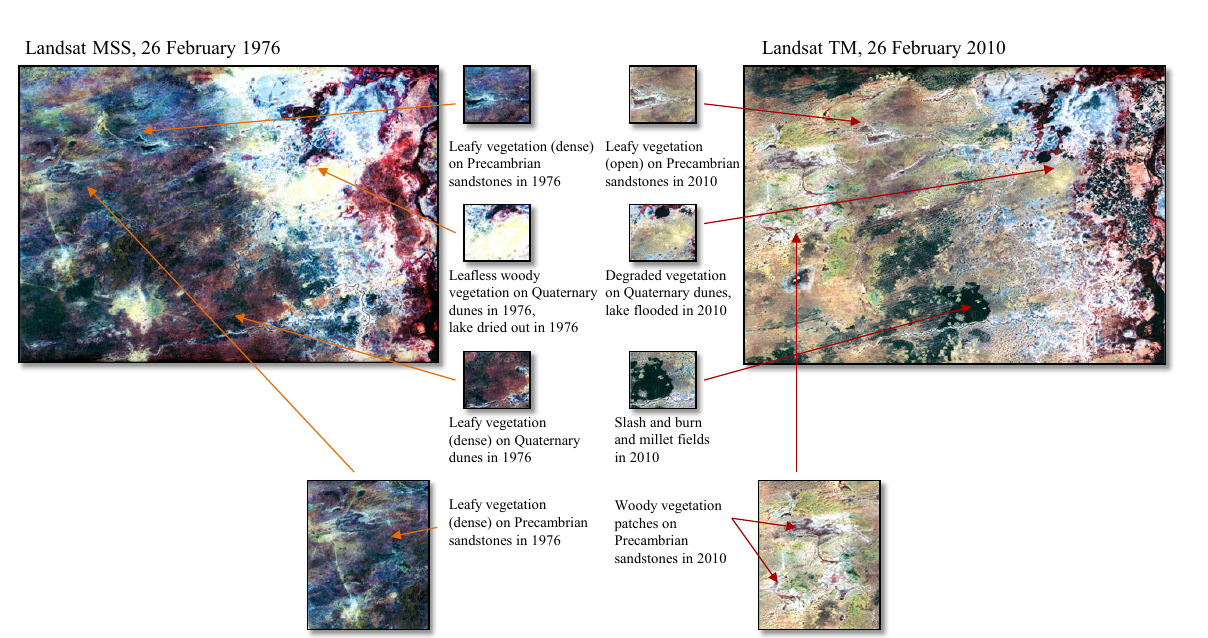
Figure 14. Development of vegetation pattern in the Canal du Sahel region in Mali over a period of 36 years (1976–2010; size of subset is approx. 80km ×